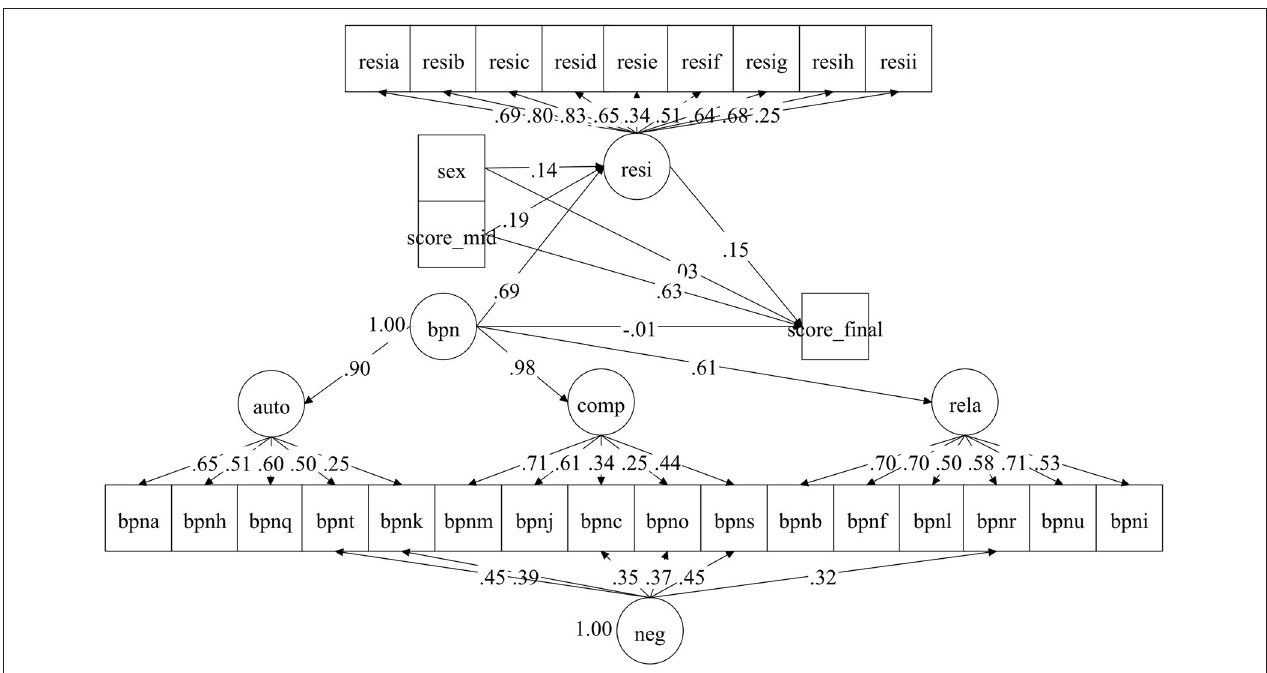
FIGURE 2 | Standardized latent path relationship between basic psychological needs, resilience, and academic performance. Resi, Resilience (items numbered resia to resii); bpn, basic psychological needs (items numbered bpna to bpns); auto, autonomy; rela, relatedness; comp,